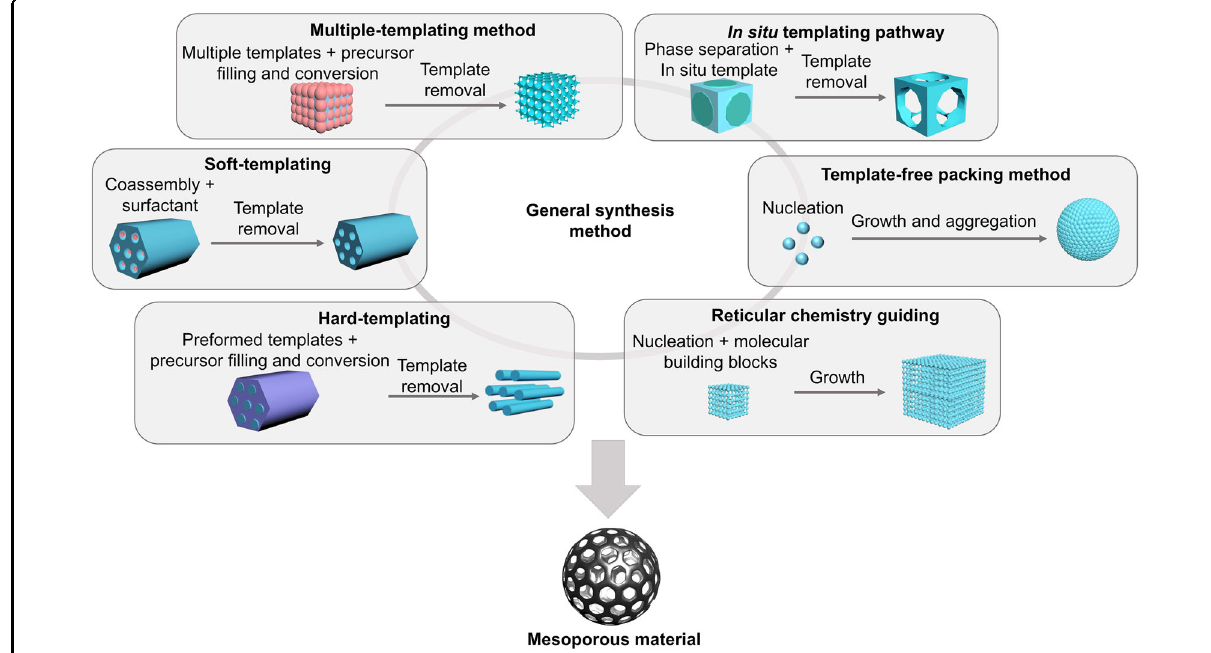
Fig. 2 Principal strategy for synthesizing mesoporous materials. There are six general methods for synthesizing mesoporous materials, including multiple-templating, in situ templating, template-free, reticular chemistry, hard, and soft templating